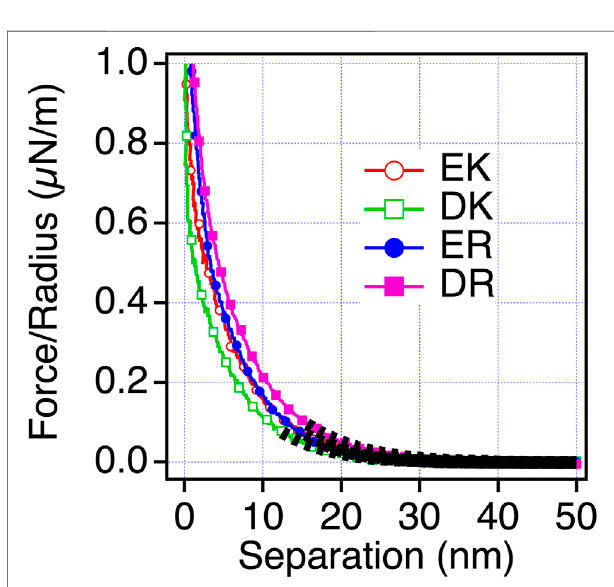
FIGURE 5 | Force-separation curves recorded on an approach for the symmetric system of the peptide-SAMs (the same SAMs prepared for both the probe and substrate) in a 1 mM PB solution. The fi tting results are shown in a black dotted line.